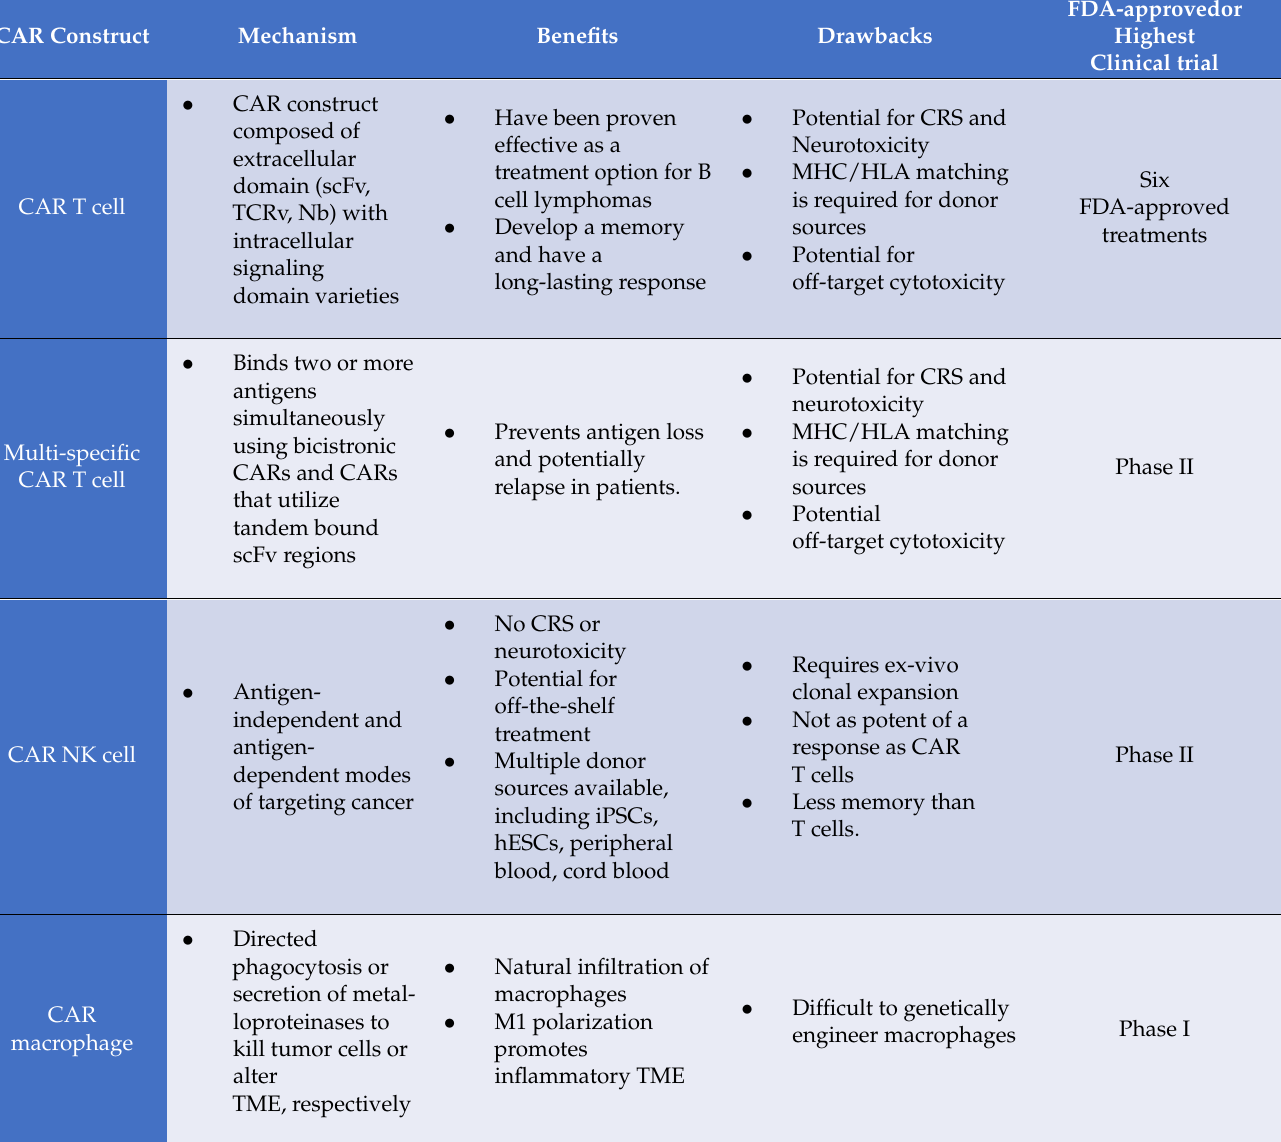
Table 1. List of CAR construct types with a summary of their general